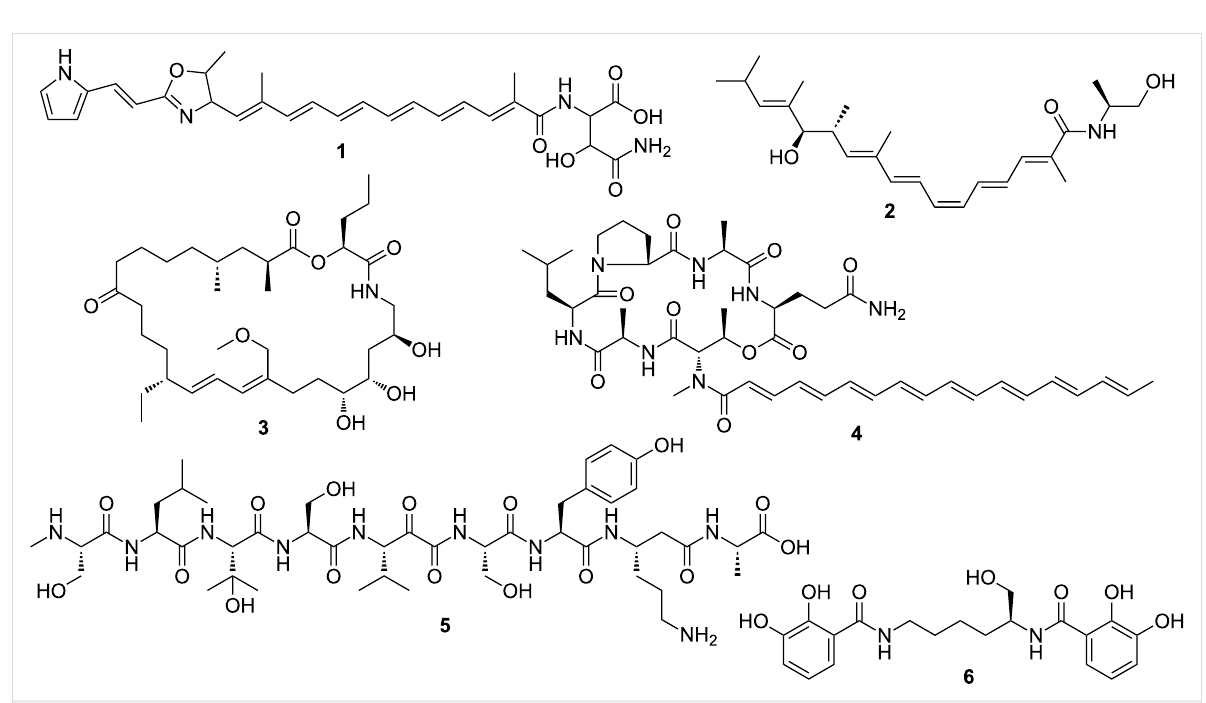
Figure 1: Natural products isolated from M. xanthus DK1622. DKxanthene-534 ( 1 ); myxalamid B ( 2 ); myxovirescin A 1 ( 3 ); myxochromide A 3 ( 4 ); myxoprincomide ( 5 ); myxochelin A ( 6